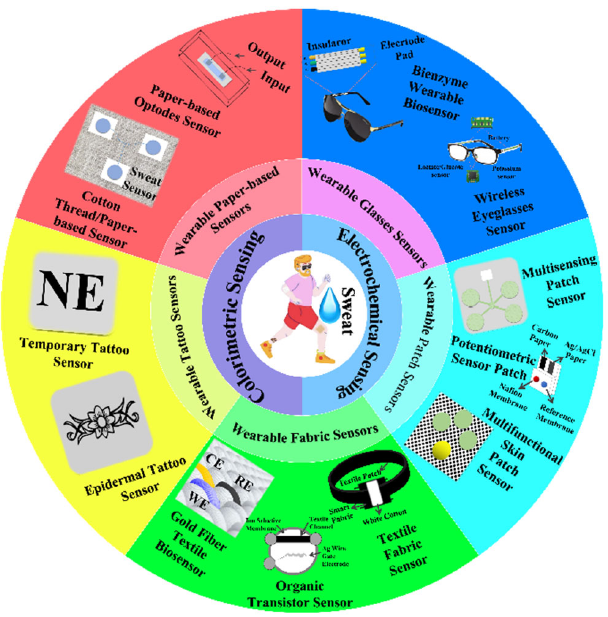
Figure 2. The representative examples of sweat based wearable electrochemical sensors. Starting from the top including five types of wearable glasses sensors, wearable patch sensors, wearable fabric sensors, wearable tattoo sensors, and wearable paper ‐ based sensors.